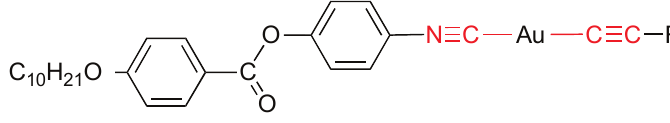
H N, C H CN, C 5 4 6 4